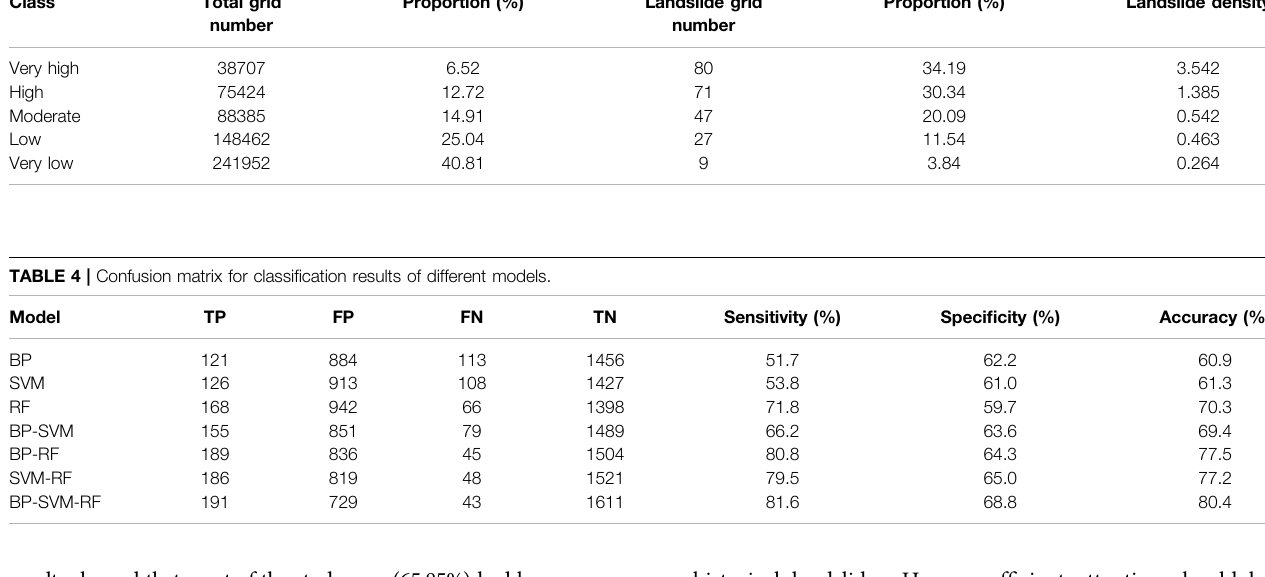
TABLE 3 | Frequency ratios of fi ve susceptibility classes assessed with the BP-SVM-RF model. Class